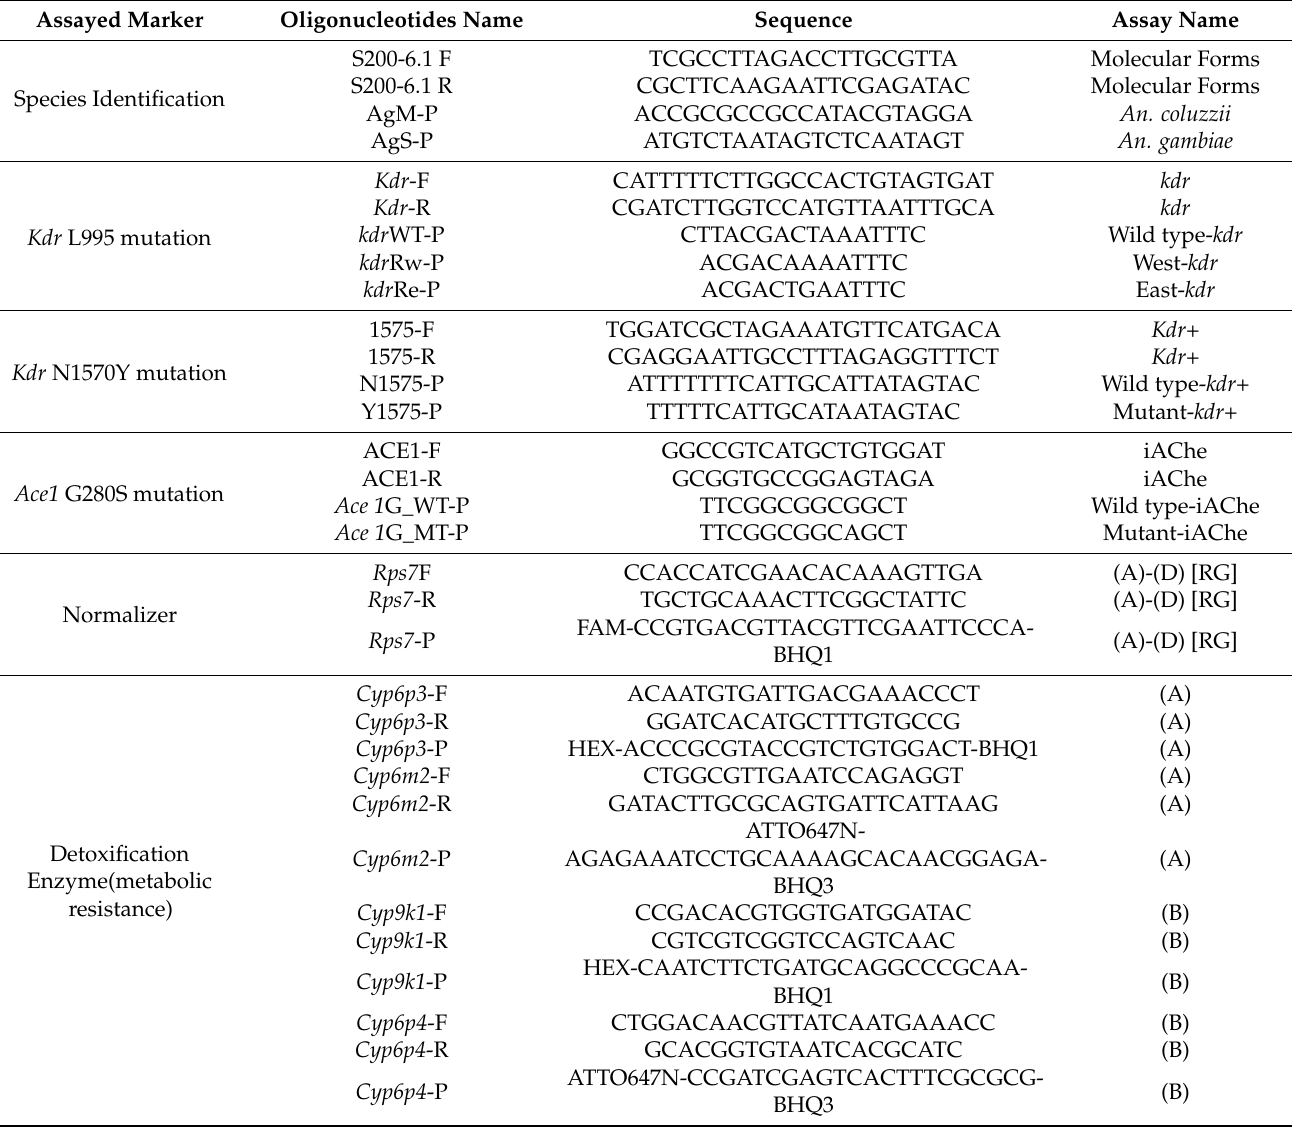
Table 5. List of probes and primers used for molecular